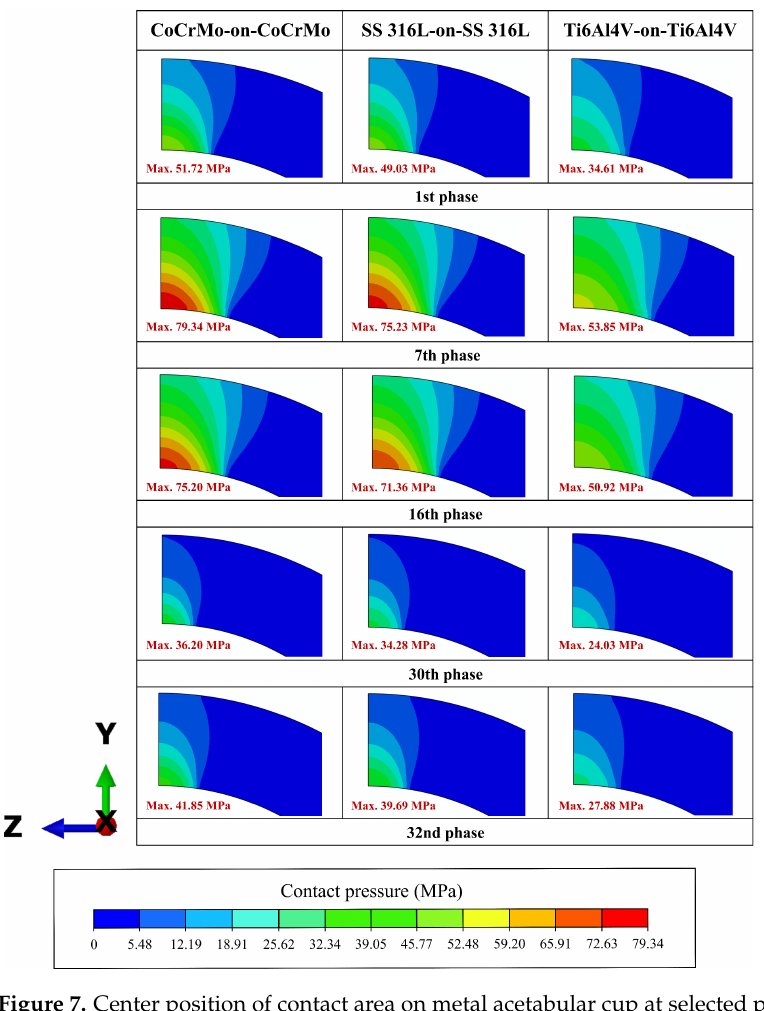
Figure 7. Center position of contact area on metal acetabular cup at selected phases. Metals 2022 , 12 , 1241